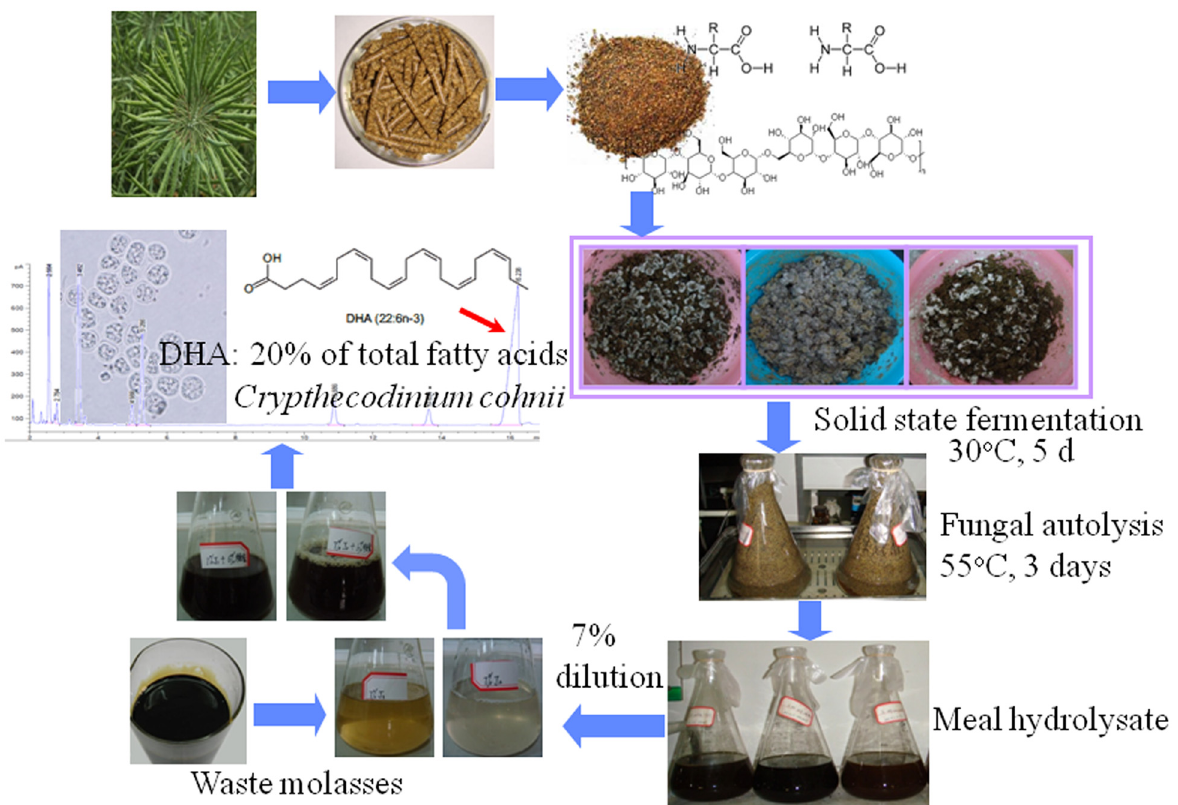
Fig 1. Schematic diagram of the novel DHA production process using by-products for microalgal fermentation. The rapeseed meal hydrolysate was obtained through the treatment of solid state fermentation followed by fungal autolysis. It was used as organic nitrogen source, and the hydrolyzed waste molasses was used as organic carbon